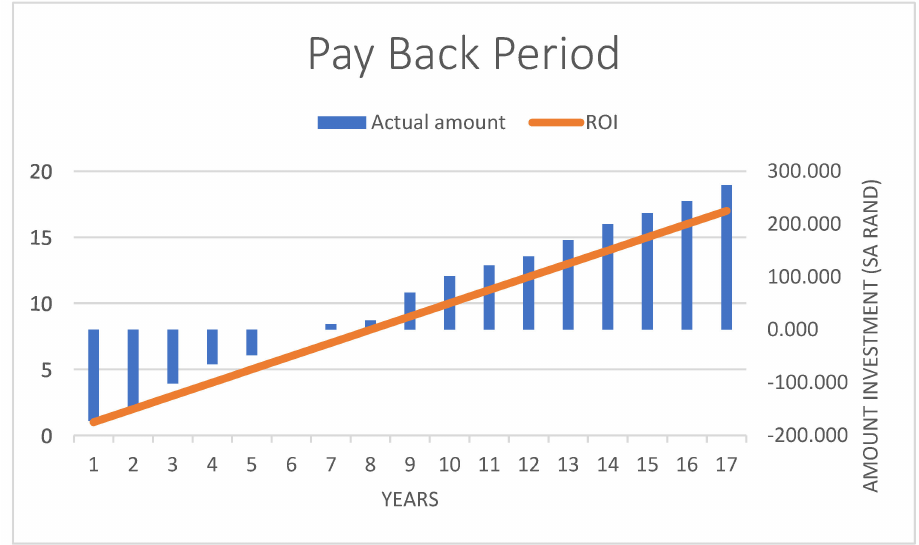
Figure 3. Payback period on solar power implementation